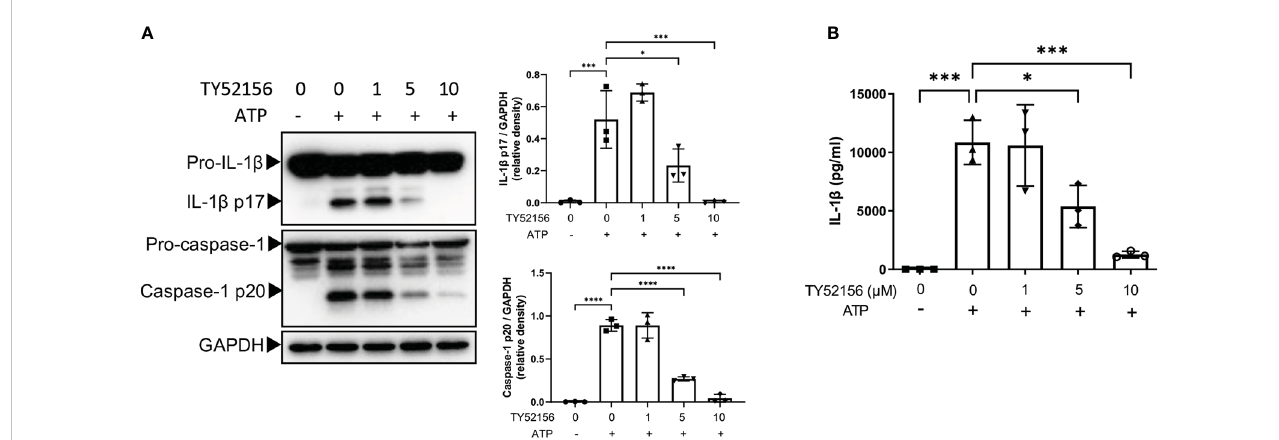
FIGURE 2 Inhibition of S1PR3 suppresses NLRP3 in fl ammasome activation induced by ATP. (A, B) BMDMs were primed with LPS (1 m g/mL) and treated with TY52156 (0, 1, 5, 10 m M) for 3.5h, followed by ATP (3mM) stimulation for 30 min. Pro-IL-1 b , IL-1 b p17, pro-caspase-1, and caspase-1 p20 in BMDMs were measured by Western blot (n= 3) (A) . IL-1 b in the supernatant was measured by ELISA (n= 3) (B) . Values are presented as mean ± SD. *p < 0.05, ***p < 0.001, ****p < 0.0001, one-way ANOVA.